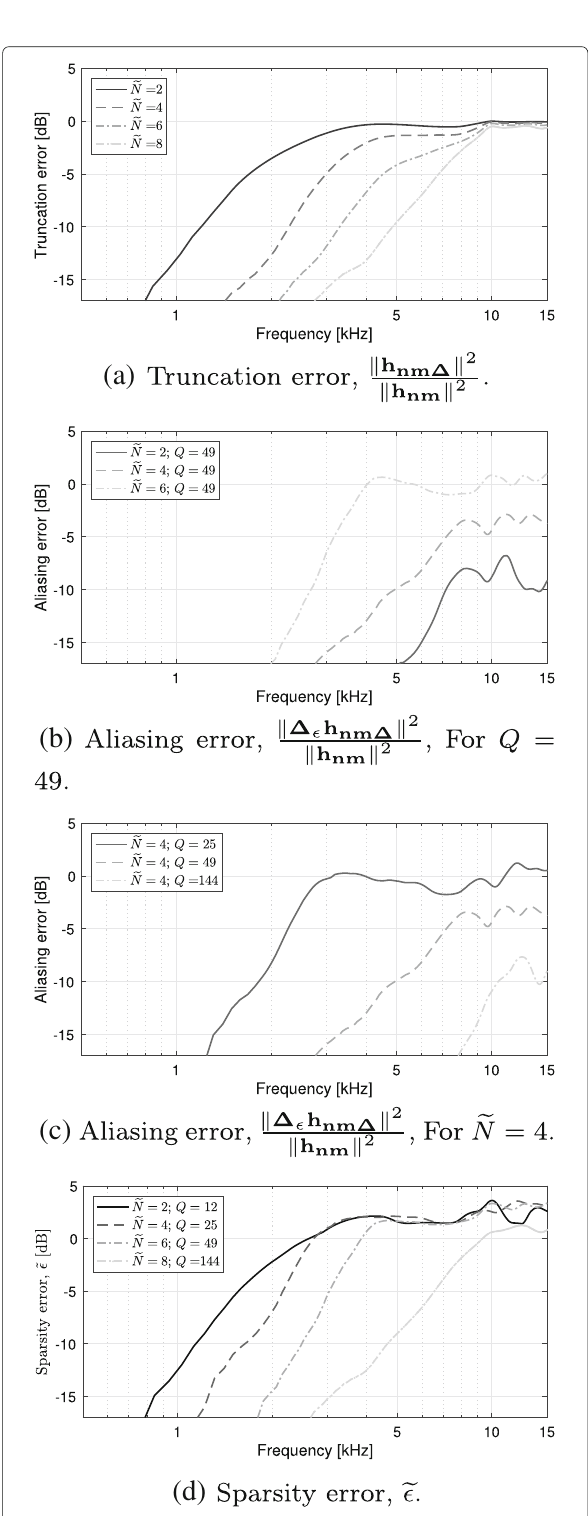
Fig. 2 Sparsity error, (cid:11) (cid:8) , for left ear HRTF, computed as in Eq. (11), with different numbers of measurement points and different SH orders: a shows the truncation error, b and c show the aliasing error for a constant number of measurements and for a constant truncation order, respectively, and d shows the total sparsity